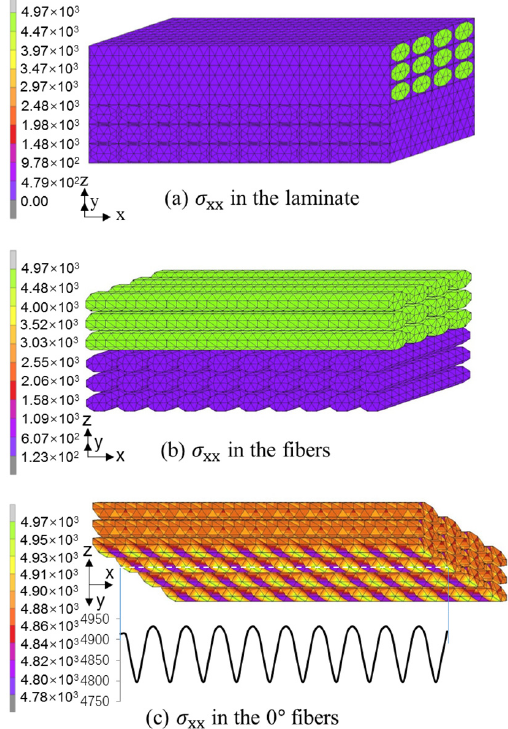
Polymers 2021 , 13 , x FOR PEER REVIEW 15 of 19